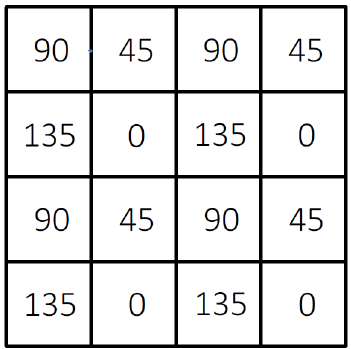
Figure 4. Polarization coding of physical pixel array, © Allied Vision Technologies GmbH Copyright